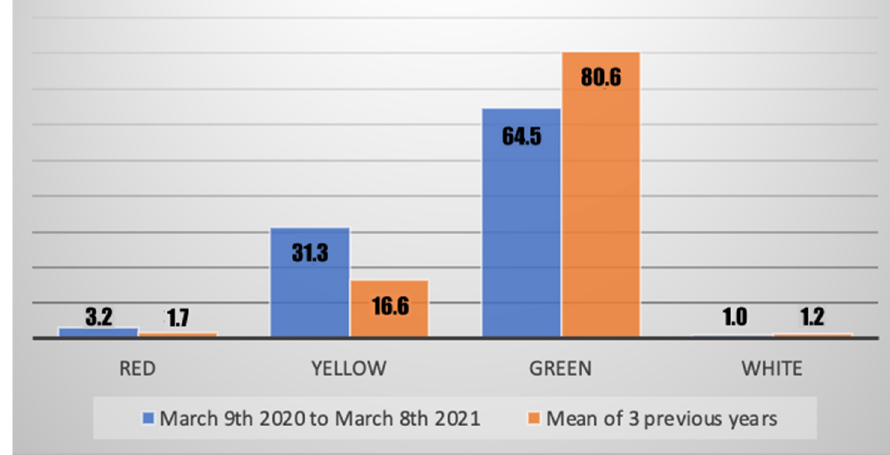
Figure 1. Comparison of severity color code (in percent) of hand injuries reaching our ED before and during the COVID-19 pandemic.